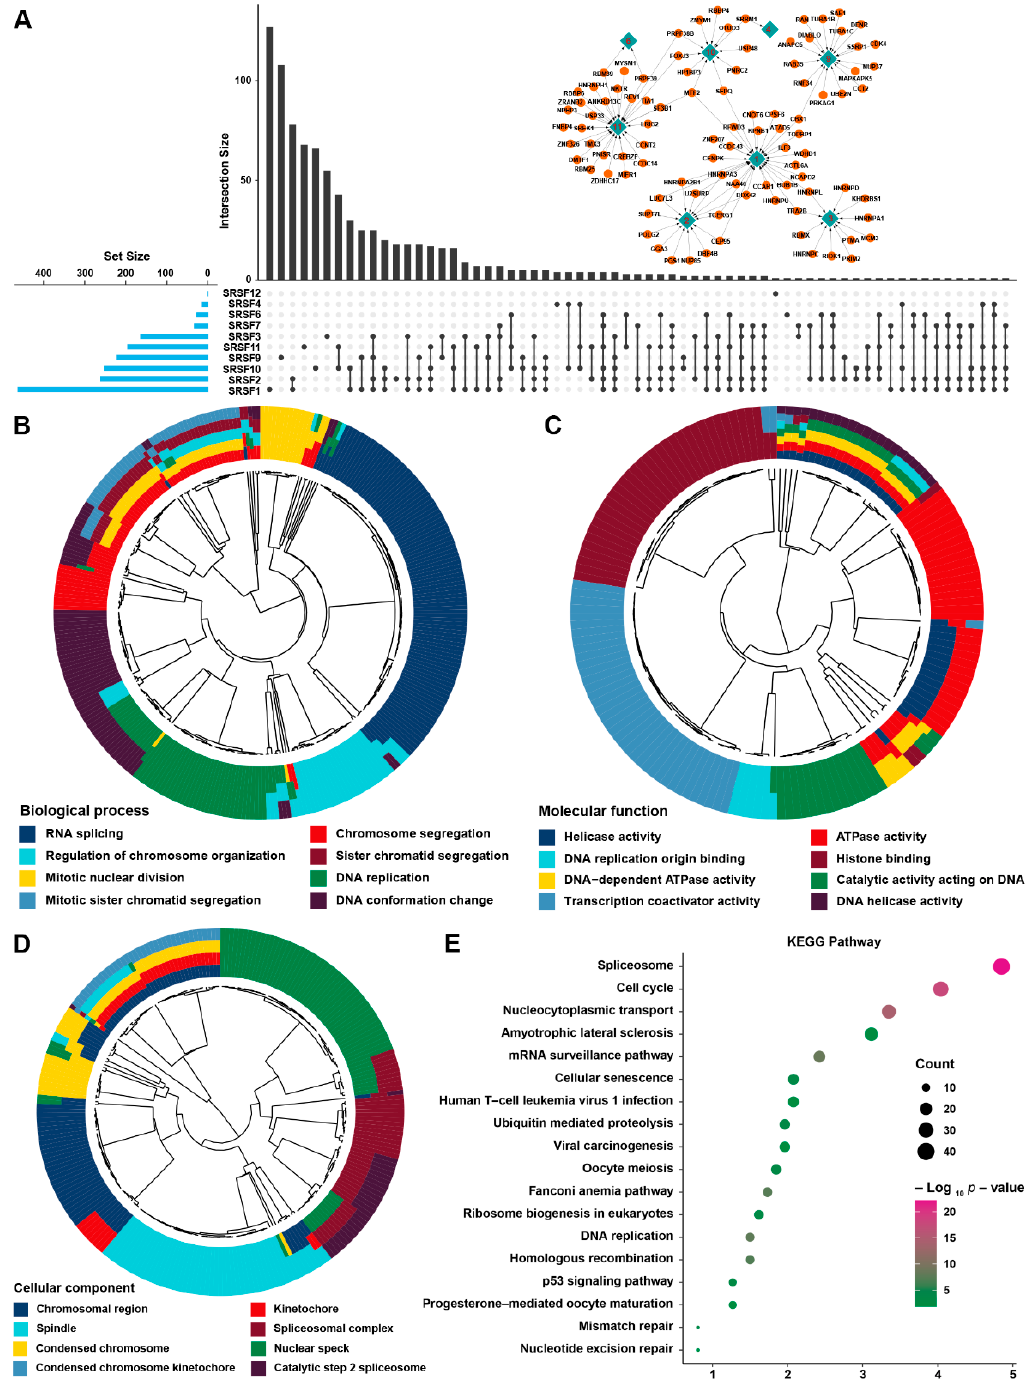
Figure 3. Construction of the SRSF family-based signature and its biological function analysis. ( A ) Venn diagram showing the specific or intersecting genes correlated with SRSF family members. The column on the left shows the sum of genes correlated with one of the SRSF family members, while the upper column shows intersection genes correlated with the SRSF family members. The specific correlation network containing genes with coefficients greater than 0.7 is shown in the upper right.